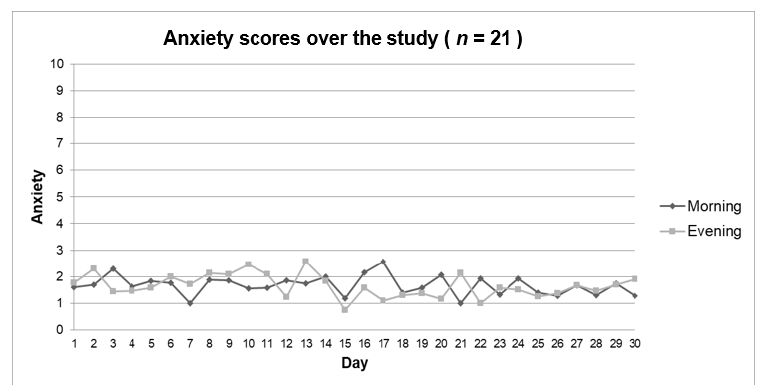
Figure A3. Graphical Representation of Anxiety Over the Study.